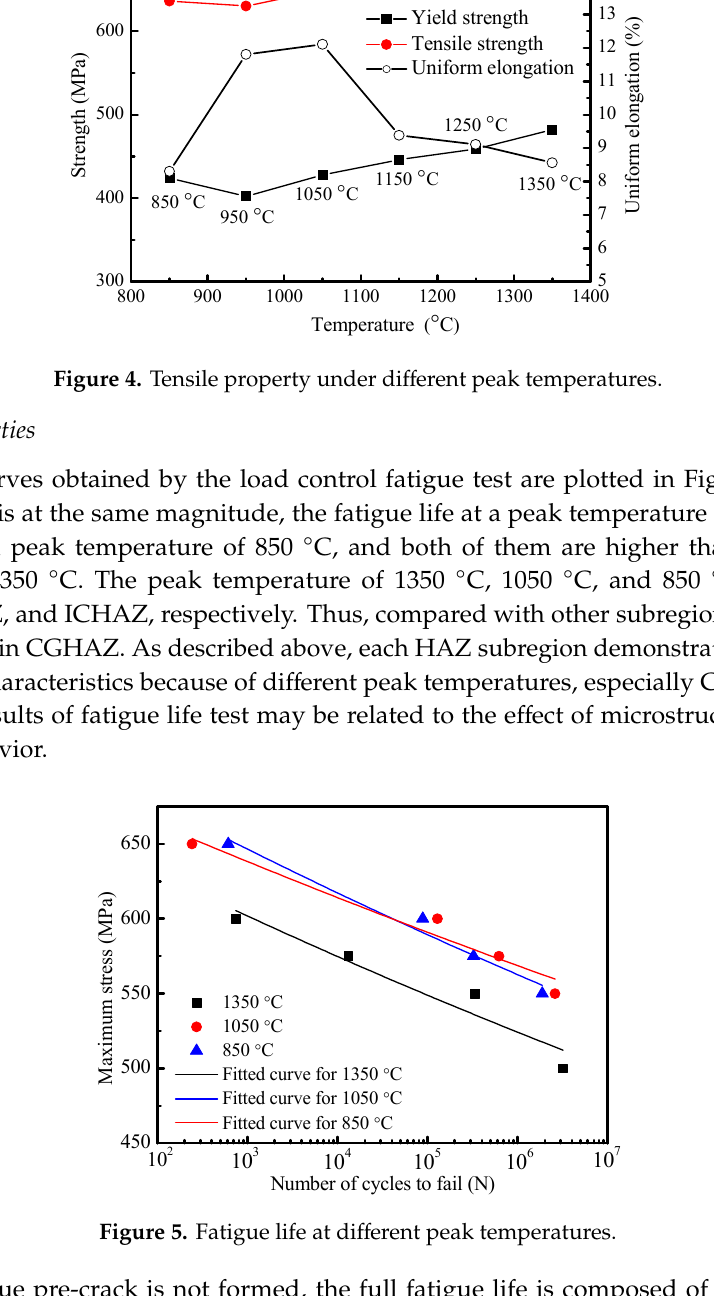
Figure 3. OM images of the simulated welded microstructures ( a ) 1350 °C; ( b ) 1250 °C; ( c ) 1150 °C; ( d ) 1050 °C; ( e ) 950 °C; ( f ) 850 °C.